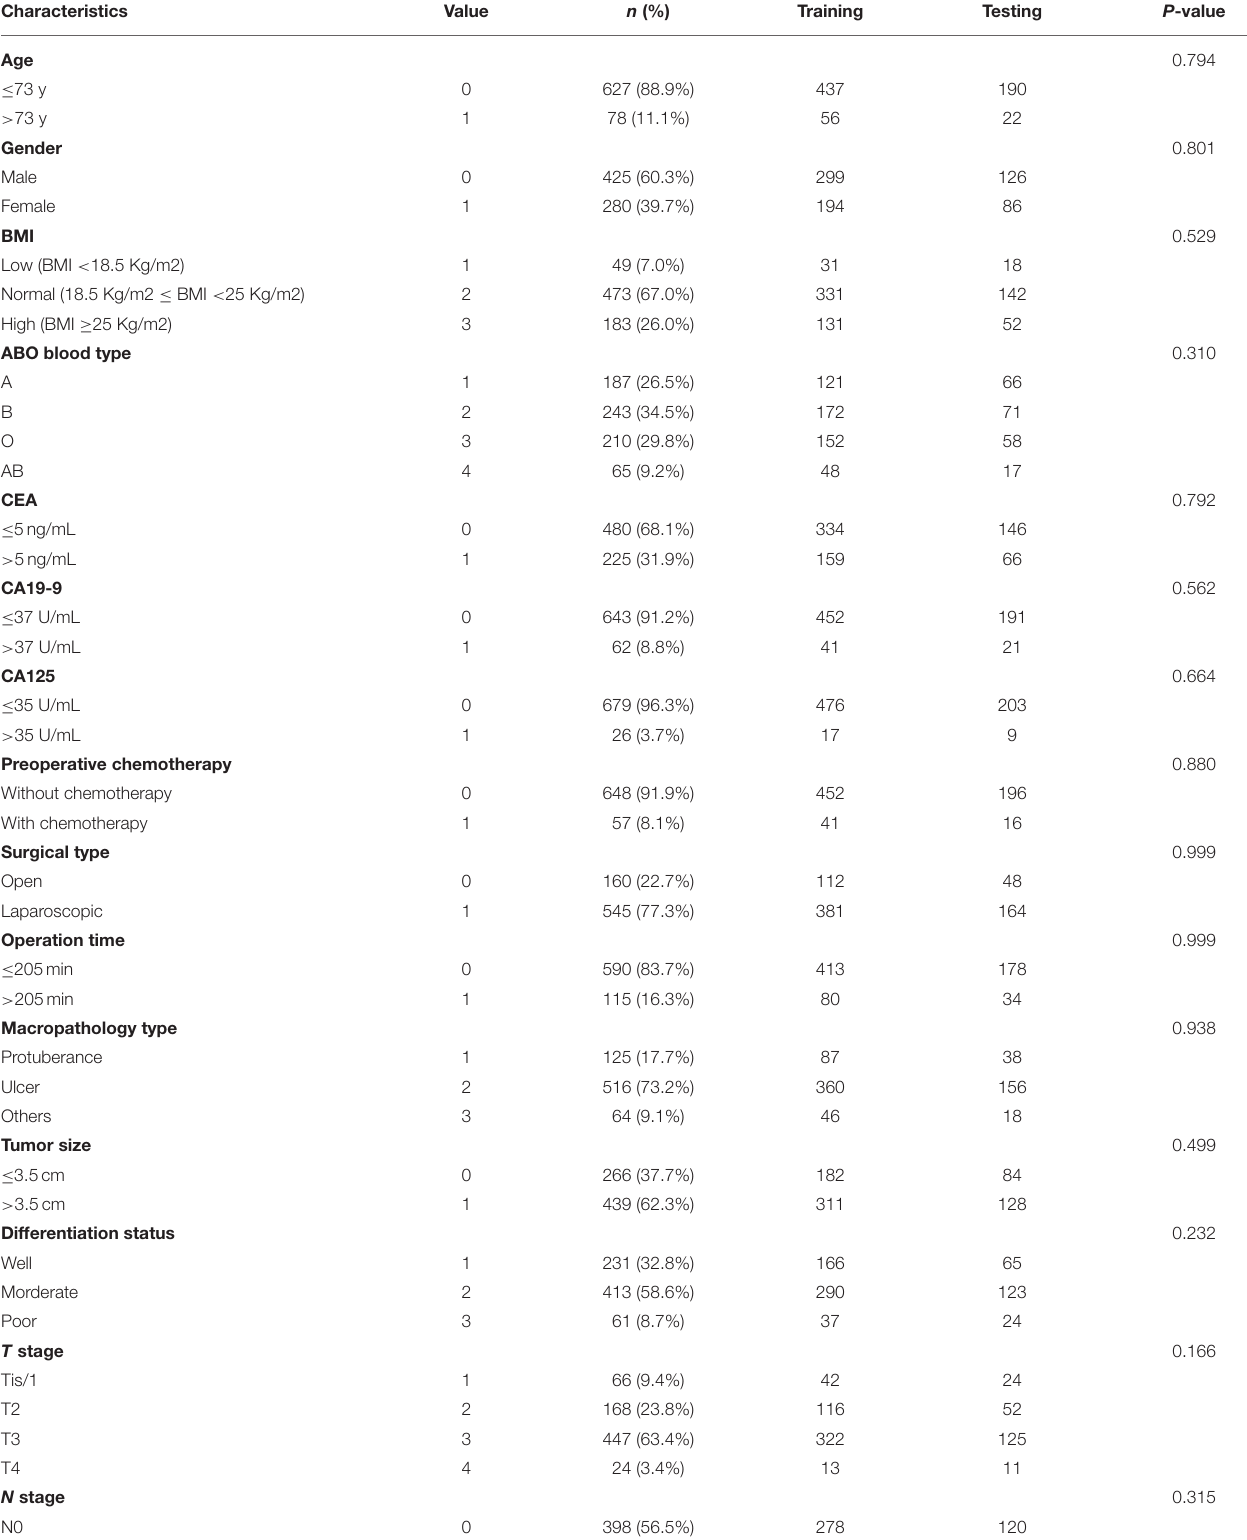
TABLE 1 | Clinicopathological characteristics of the entire cohort and the comparison of variable consistency between training and testing dataset.